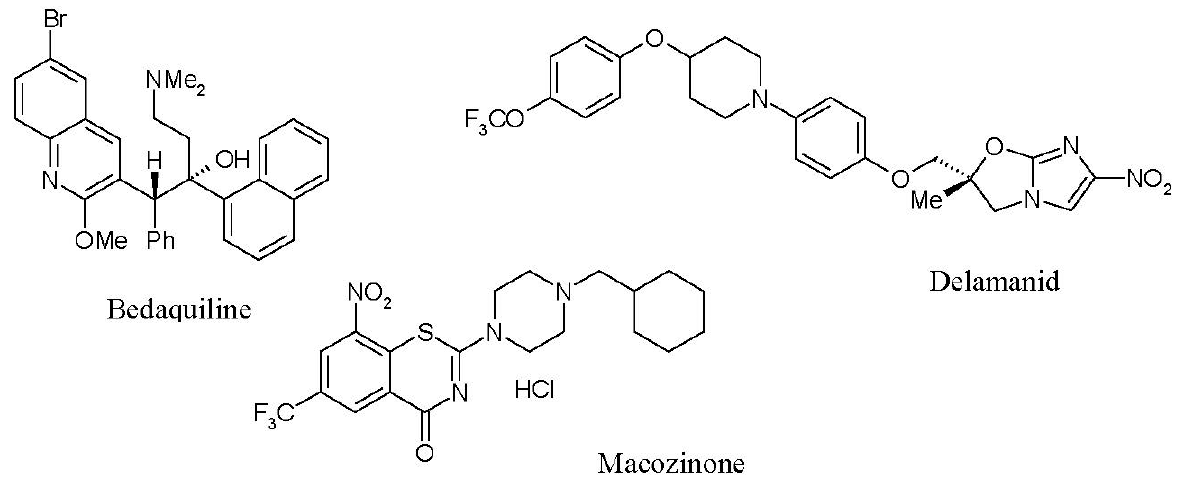
Figure 1. Chemical structures of novel antitubercular compounds.